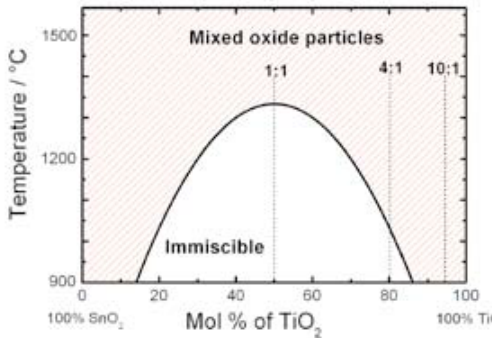
Fig.6 Frequency-dependent conductance G ’ for different mixtures of TiO 2 and SnO 2 . Fig. 5 Phase diagram of the SnO 2 /TiO 2 system, adapted from 32)